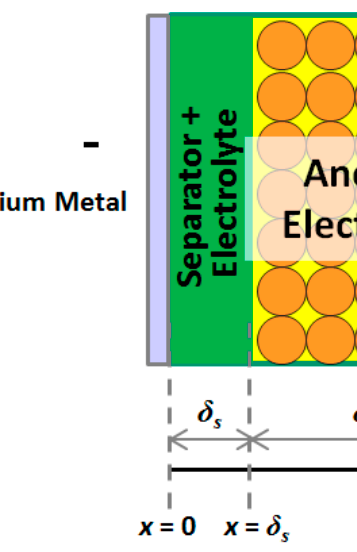
Figure 7. Ion concentrations in the electrolyte of graphite and LTO half-cells while cycling at 0.045 C, 0.089 C, and 0.13 C.